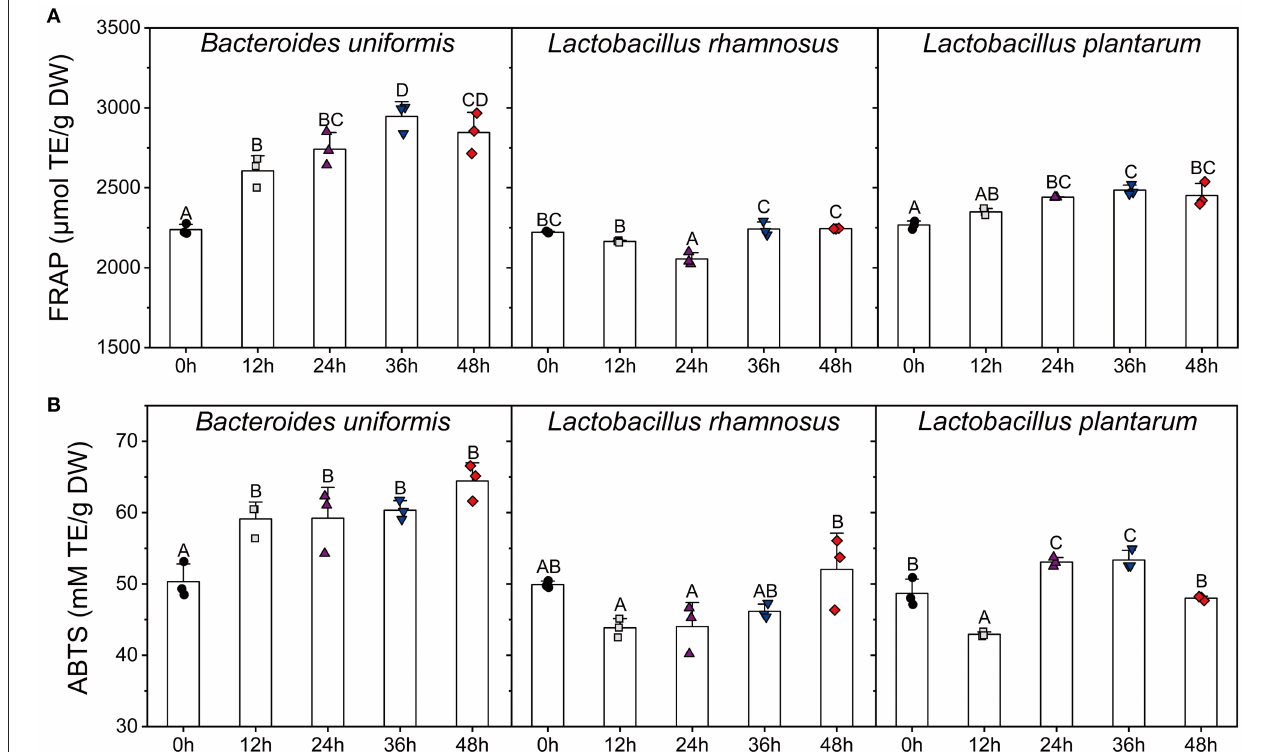
FIGURE 6 | Changes in FFAR (A) and ABTS (B) scavenging capacity of the supernatants of different microbial cultures ( B. uniformis , L. rhamnosus , and L. plantarum .) during fermentation with LPP. Bars with no letter in common are significantly different ( p < 0.05). FRAP, ferric reducing antioxidant